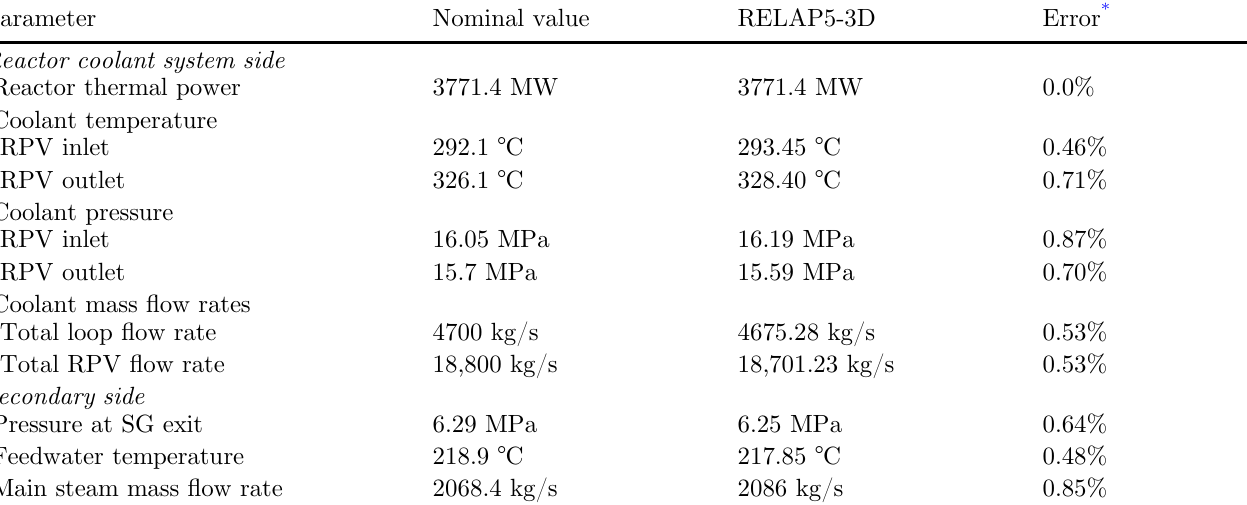
Table 3. Comparison between the steady state thermal hydraulic parameters calculated by RELAP5-3D code and FSAR